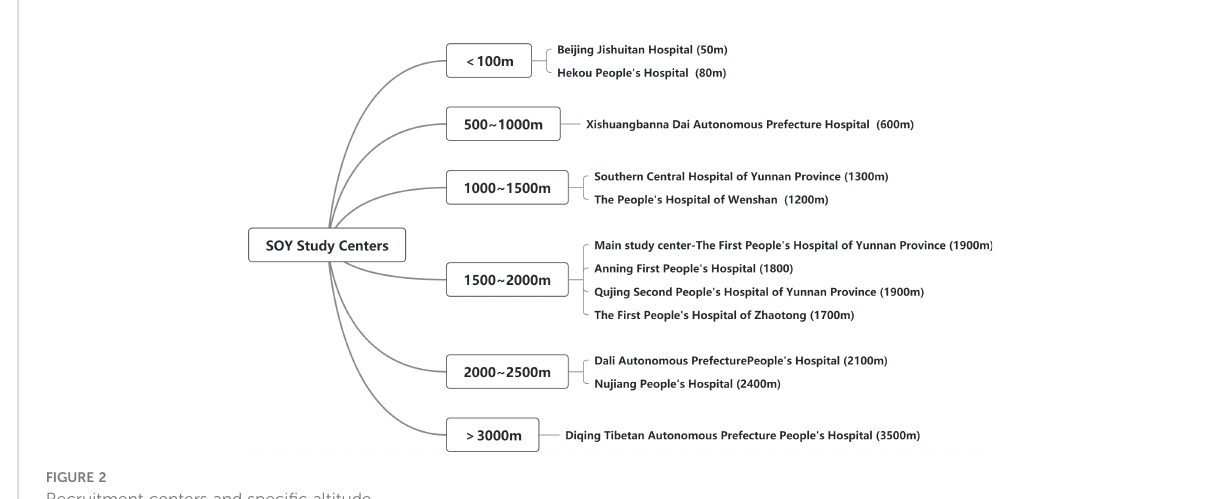
FIGURE 2 Recruitment centers and speci fi c